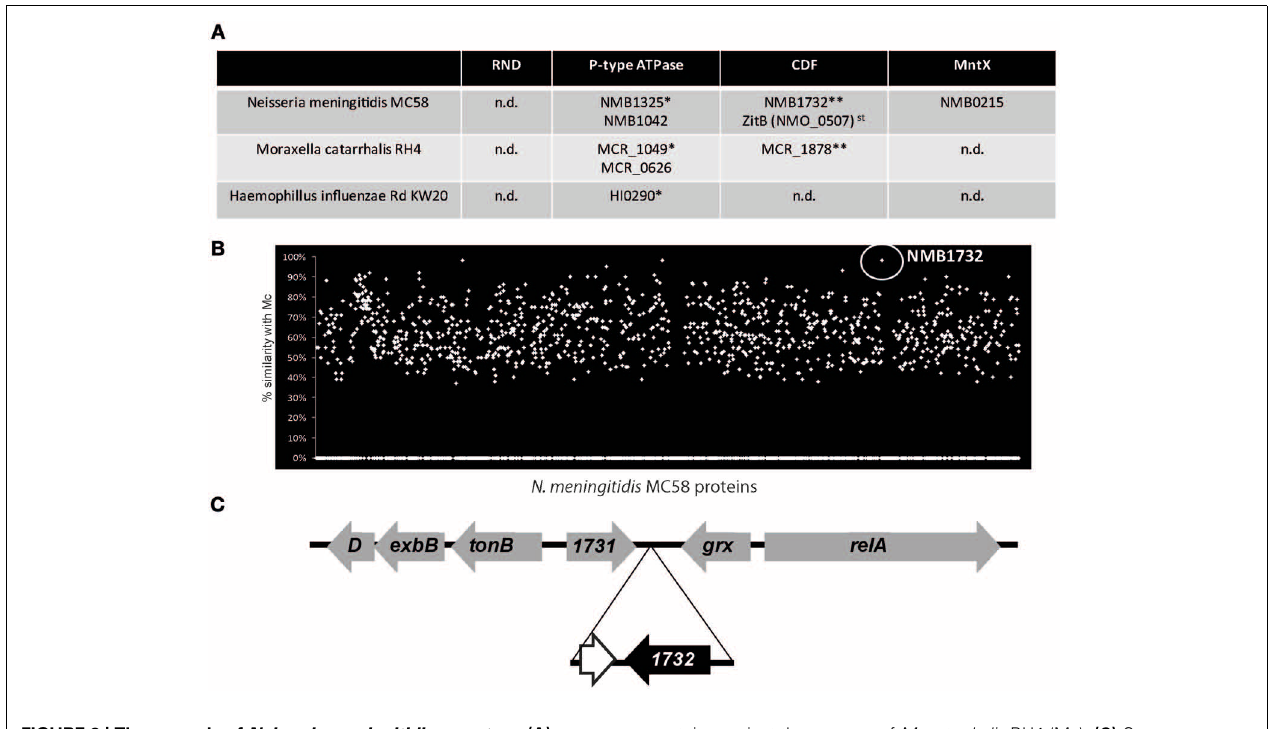
FIGURE 2 | The example of Neisseria meningitidis exporters. (A) Candidate for metal exporters encoded in the genomes of three nasopharyngeal pathogens based on the Kyoto Encyclopedia of Genes and Genomes (KEGG database). st stands for strain specific and n.d. for not detected. ∗ and ∗∗ represents groups of putative homologous genes determined using blastp similarity. (B) TBlastN of N. meningitidis MC58